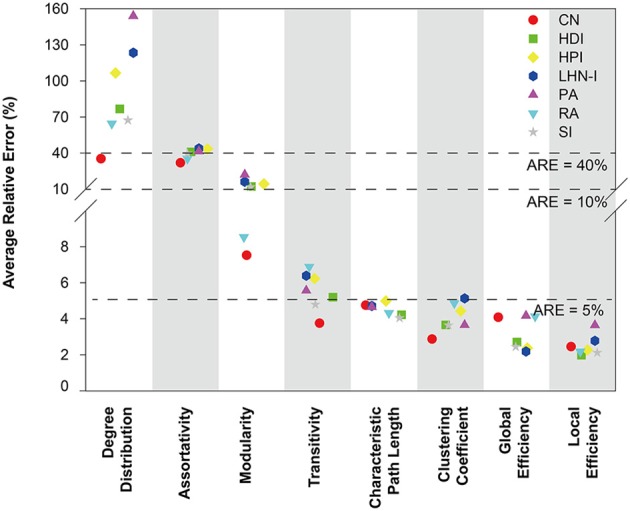
Average relative error of seven selected local information indices for different topological properties. The mathematical definition of relative error is |(pd-pm)pd|×100%. Topological properties were sorted by average relative error. The results showed that the average relative errors of four properties were around or below 5%. CN, common neighbor; HDI, hub depressed index; HDI, hub promoted index; LHN-I, Leicht-Holme-Newman index; SI, Sørensen index; PA, preferential attachment index; RA, resource allocation index.